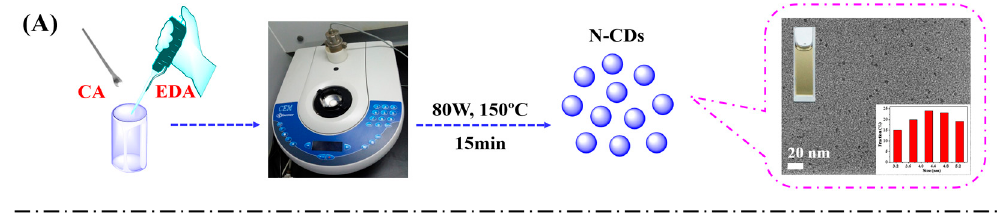
Scheme 1. Cont. Scheme 1.